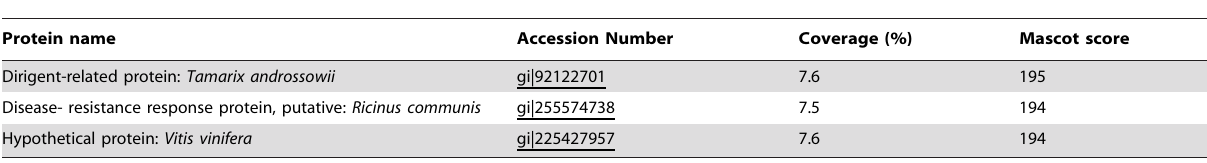
Table 6. Proteins sharing homology with sequenced peptide.